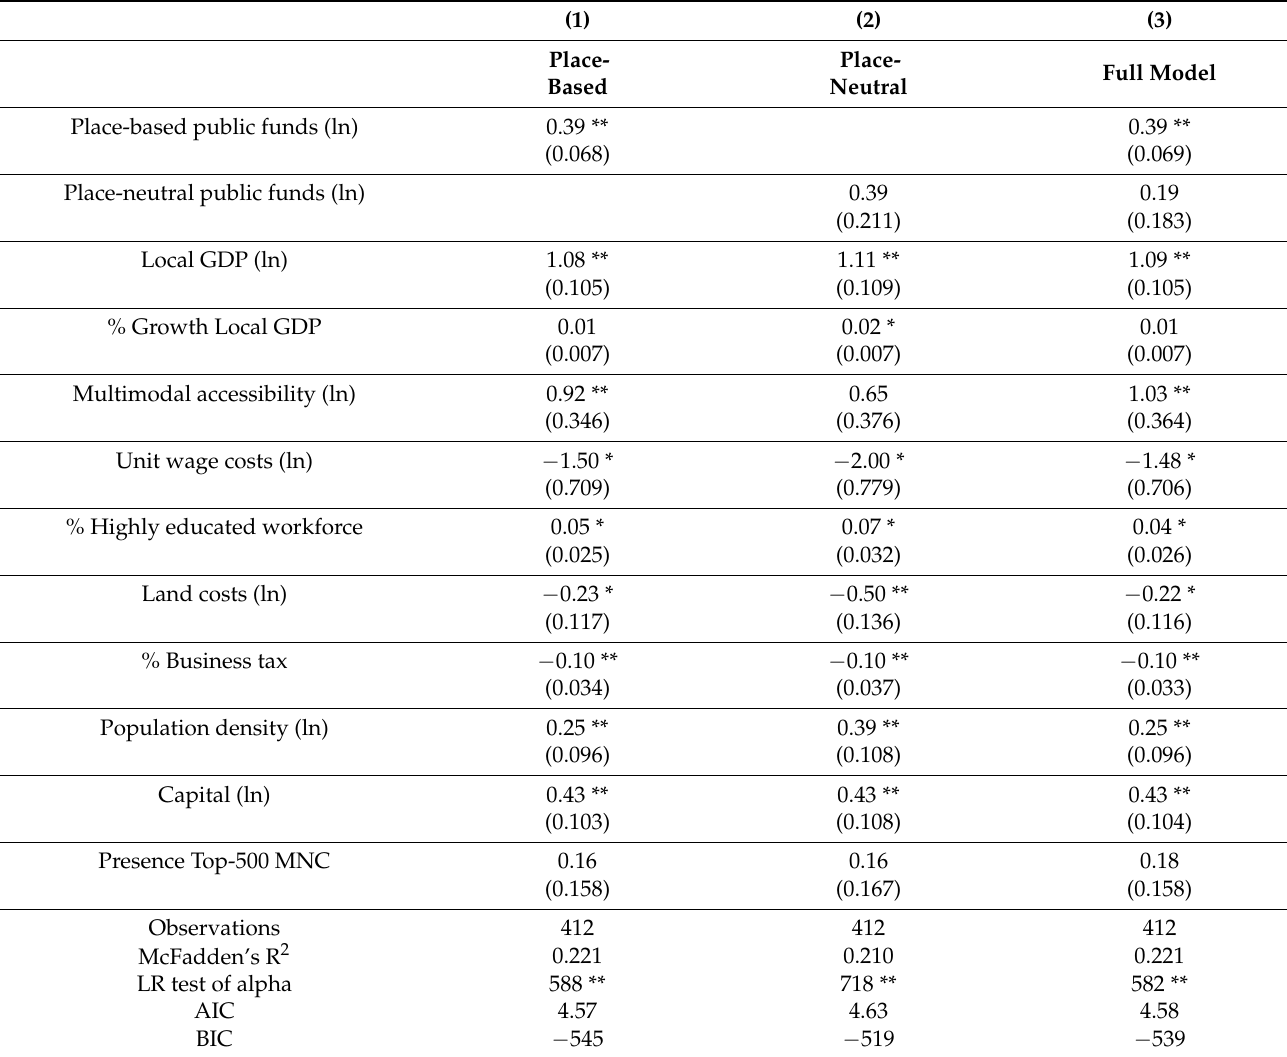
Table A3. Negative Binomial Estimations on Number of Greenfield FDI: Incentive-Based versus Capacity-Building